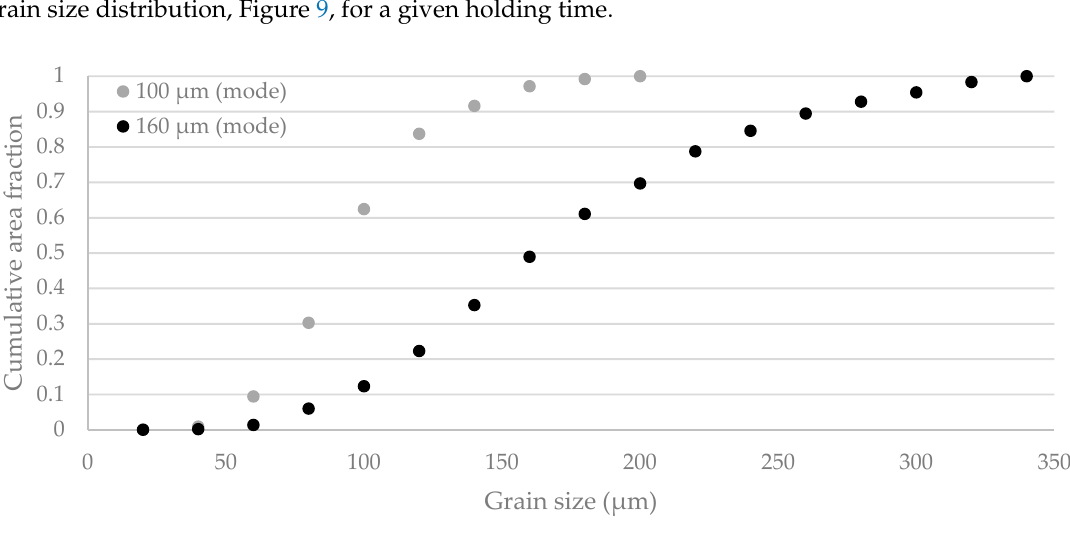
Figure 9. Cumulative area fraction representation of grain size for the two different grain size distributions.